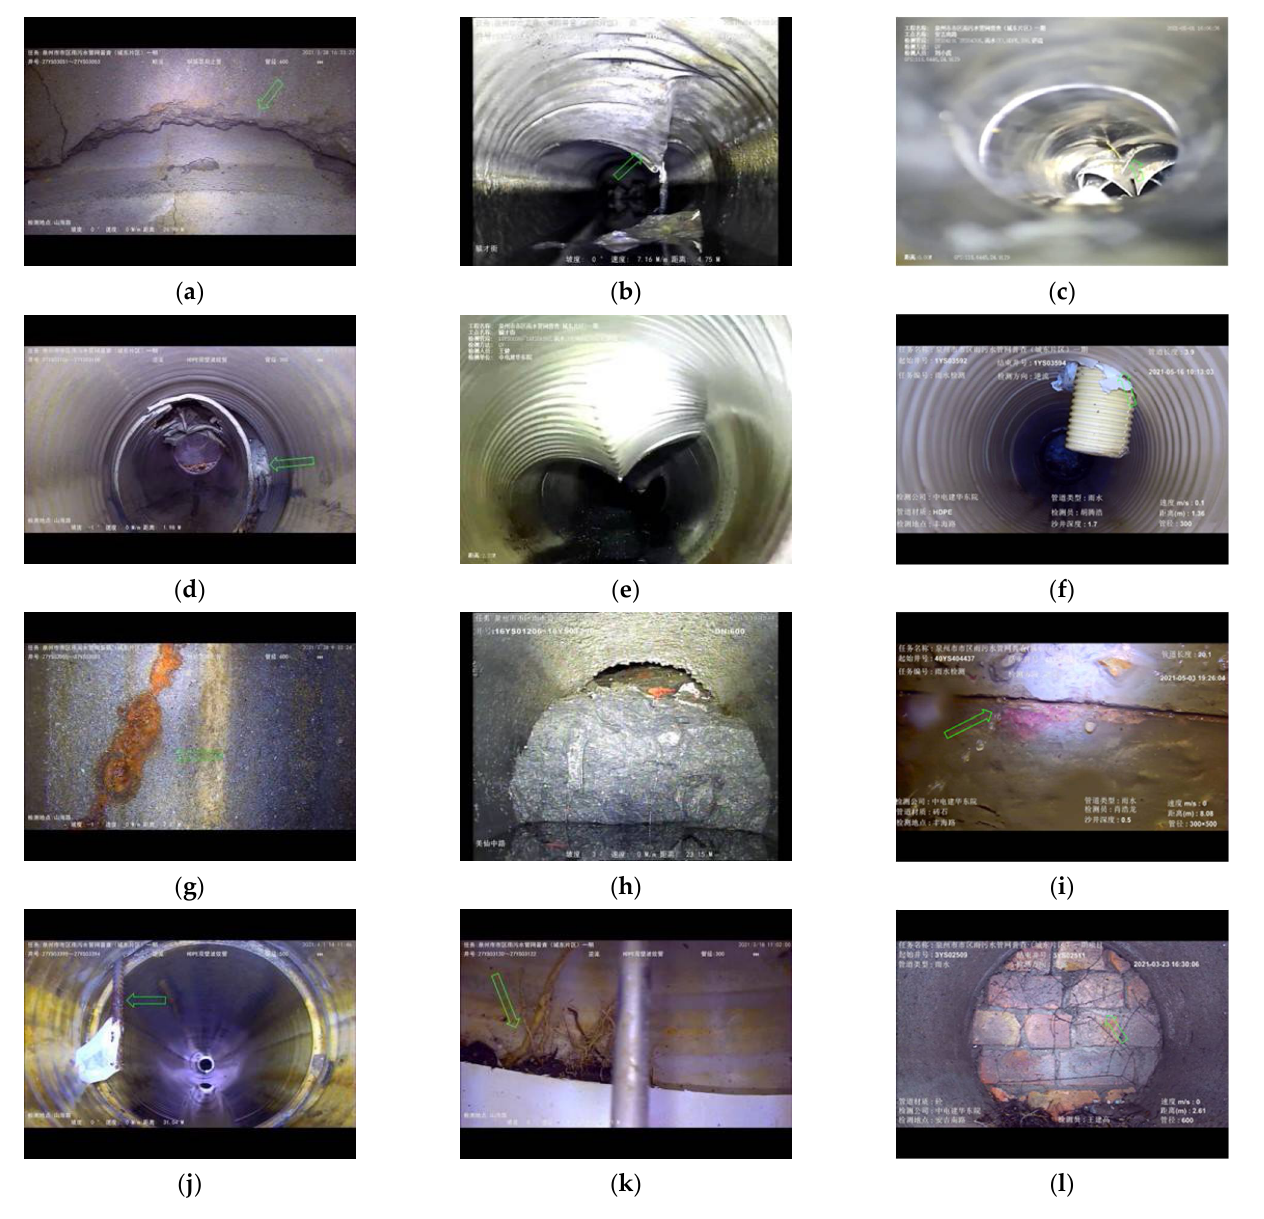
Figure 3. Typical failure patterns in sewer pipes. ( a ) Crack, ( b ) Fracture, ( c ) Broken, ( d ) Mismatch, ( e ) Deformation, ( f ) Branch Pipe Concealed Connection, ( g ) Corrosion, ( h ) Obstruction, ( i ) Leakage, ( j ) Penetration, ( k ) Root Intrusion and ( l ) Stump Walls and Roots.